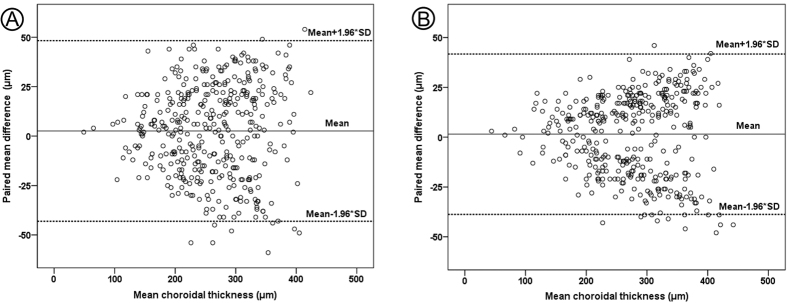
Bland-Altman plot analyses.Bland-Altman plot of interobservers agreement on choroidal thickness measurements for all locations between the two observers before (A) and after 1-week administration of 1% atropine gel (B). Solid line indicates the average mean difference, whereas dotted lines delineate 95% limits of agreement (1.96 *SD). There was no specific trend to cause the difference between the two observers.